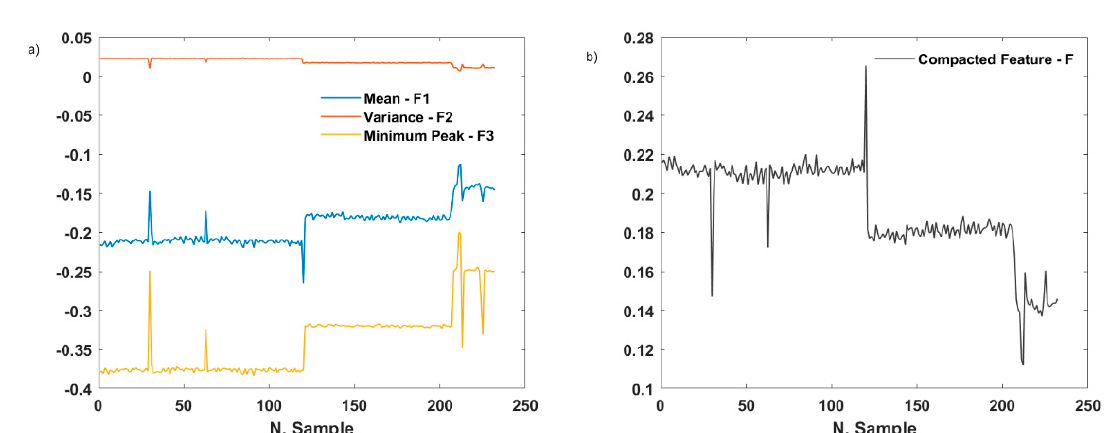
Figure 8. ( a ) Features extracted in the time-domain: F1, F2, F3. ( b ) Synthetic value computed by the extracted features: F.